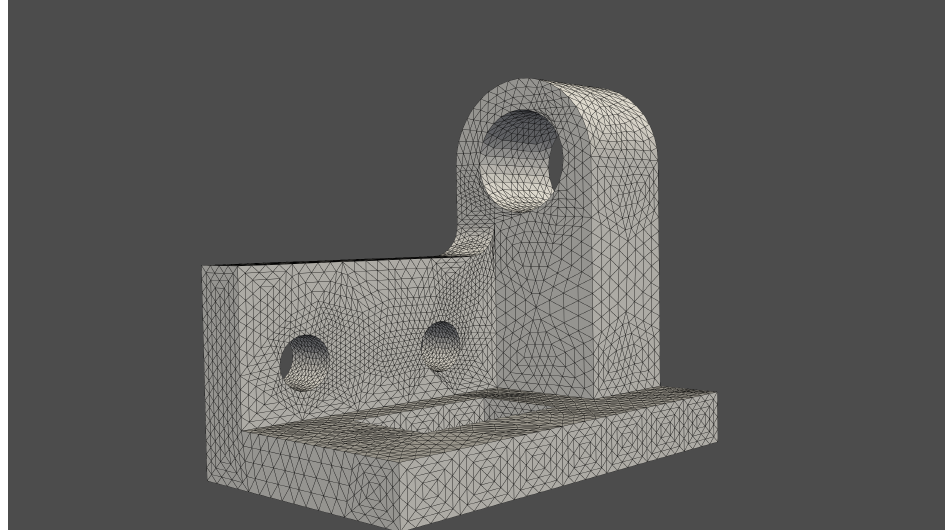
Figure 1. Bracket geometry with tetrahedron